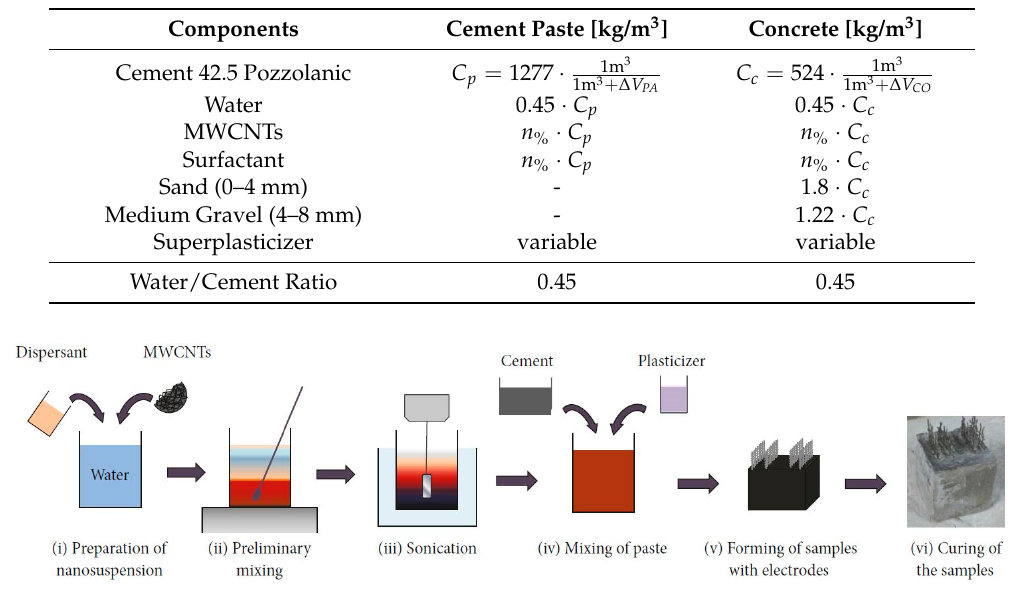
Figure 1. Preparation procedure of paste and concrete samples with carbon nanotubes.